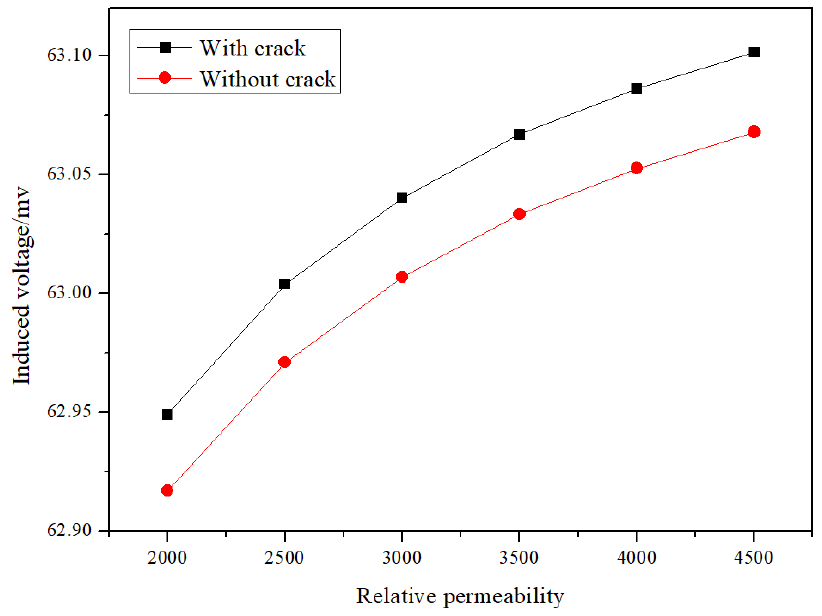
Figure 6. The variation of induced voltage of Coil 1 versus the relative permeability.